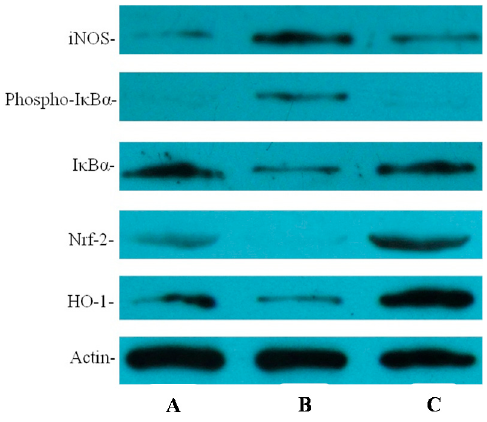
Figure 7. The effect of resveratrol on the protein levels of inducible nitric oxide synthase (iNOS), the phospho-specific form of I κ Ba, I κ Ba, Nrf2, and HO-1 in H. pylori -infected gastric mucosal tissues as determined by Western blotting. (A) Normal control animals; (B) H. pylori -infected model animals without resveratrol treatment; and (C) H. pylori -infected animals with resveratrol treatment.